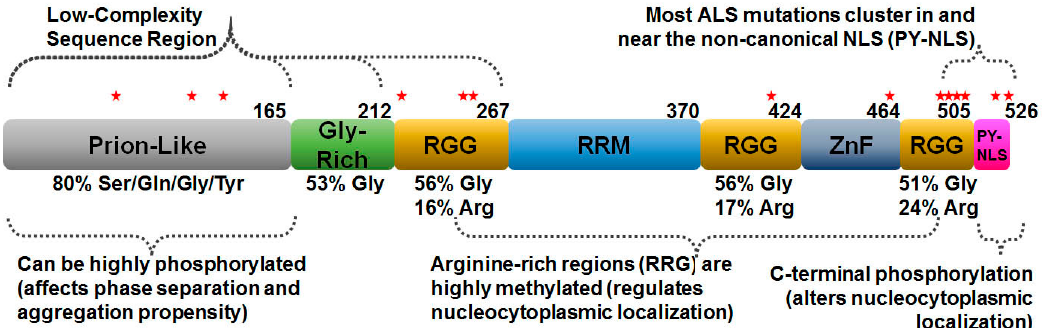
Figure 1. Schematic of human FUS domain organization. Approximately the first half of FUS has little sequence complexity and consists mostly of a few different amino acids. This region is sometimes called the low-complexity domain. The prion-like domain (PrLD) shares sequence composition with domains in yeast proteins that form self-replicating amyloid structures (i.e., prions). FUS’s PrLD is highly phosphorylated following certain stresses. The RGG domains contain the triplet repeat motif of arginine–glycine–glycine, which are extensively methylated. FUS also contains an RNA-recognition motif (RRM), a zinc-finger domain (ZnF), and a proline–tyrosine nuclear localization signal (PY–NLS). The red stars indicate ALS mutation sites that are also post-translationally modified (see Table 1). Table 1. Post-translational modifications (PTMs) of FUS.